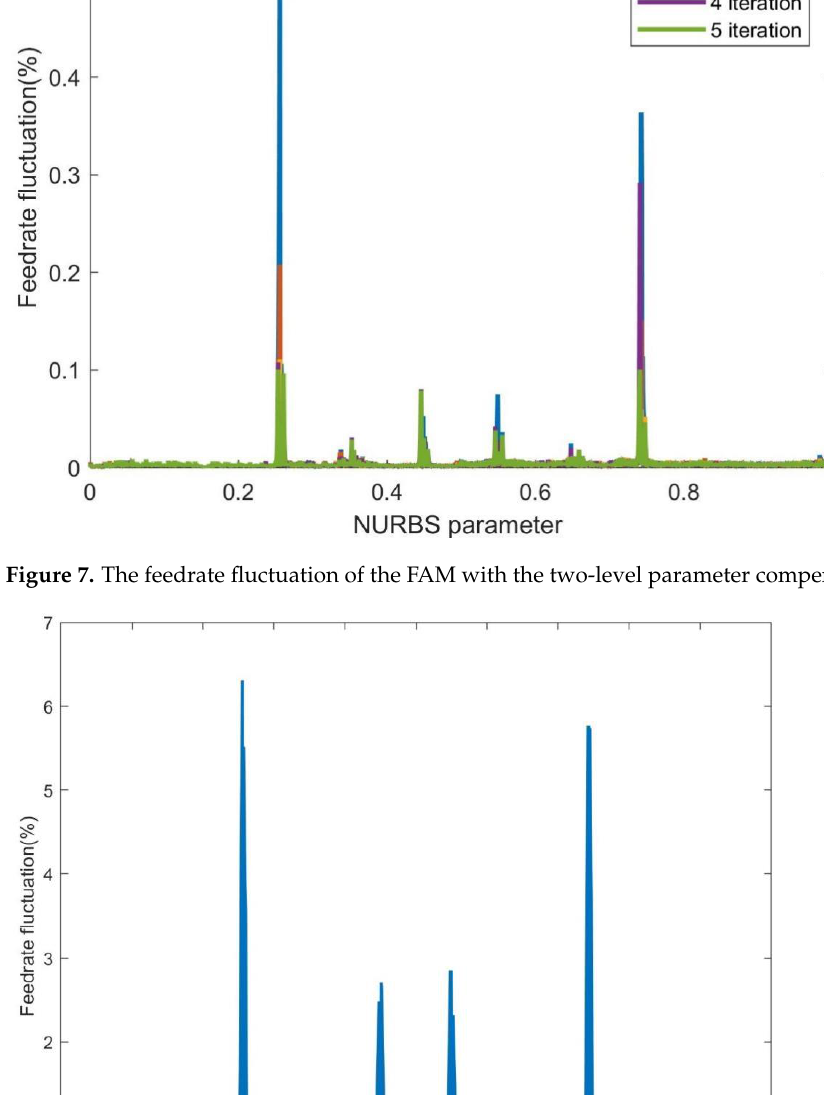
Figure 7. The feedrate fluctuation of the FAM with the two-level parameter compensation.